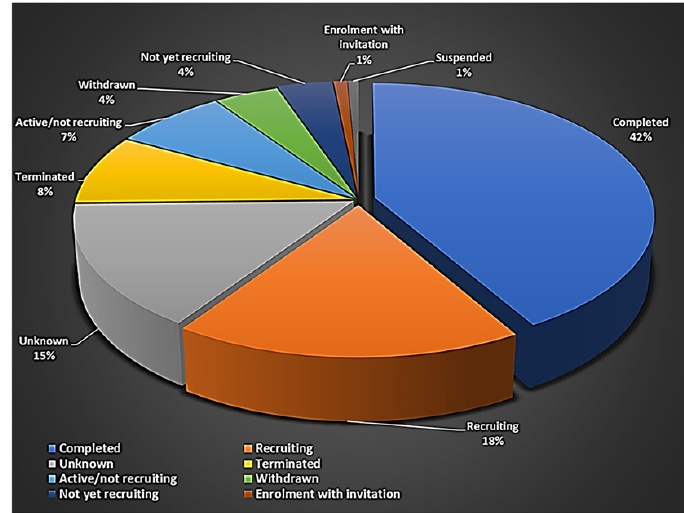
Figure 1. Status of clinical trials using stem cells.